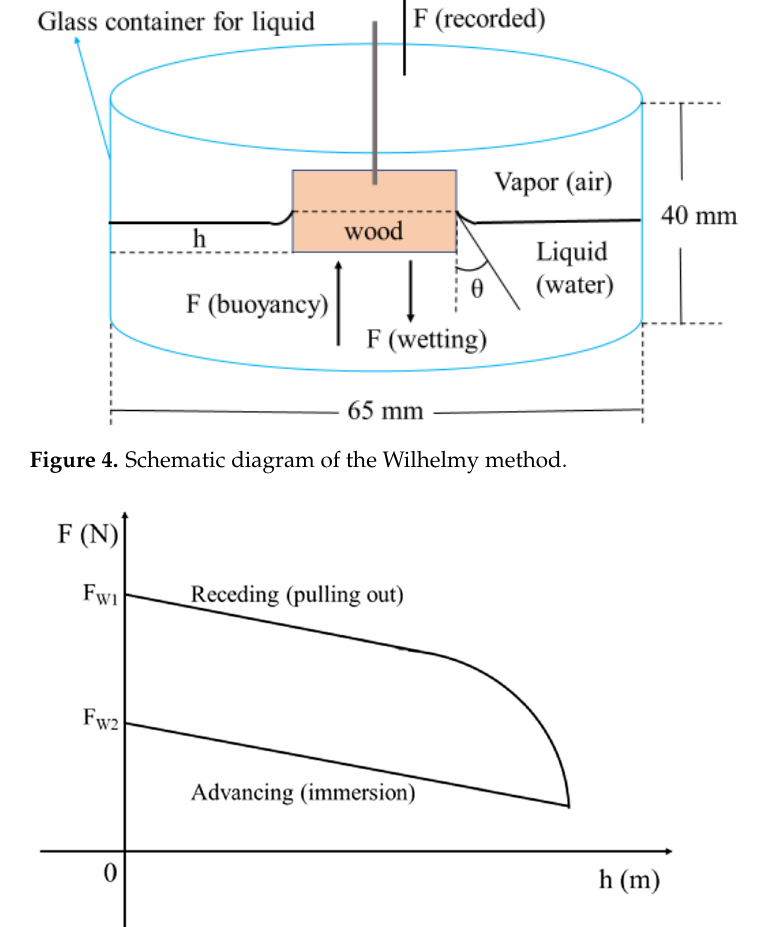
Figure 4. Schematic diagram of the Wilhelmy method.